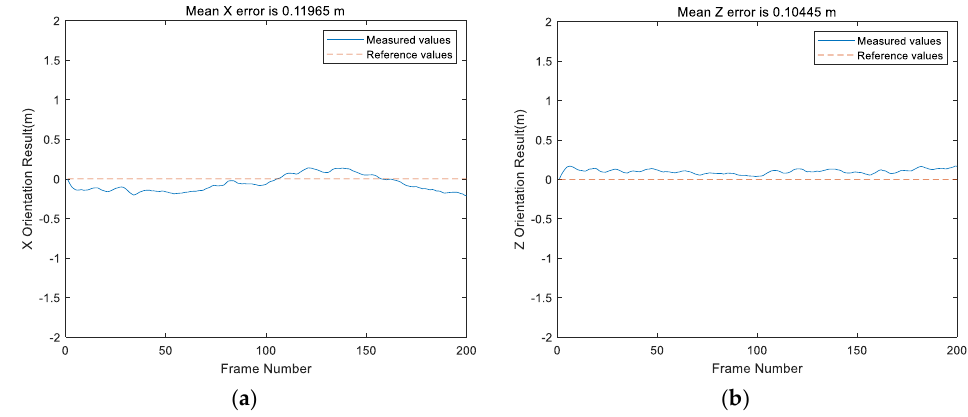
Figure 14. The singular value decomposition SVD–STKF positioning results under the source rotation for the point (0, 0). ( a ) Error in the x–direction. ( b ) Error in the z–direction.